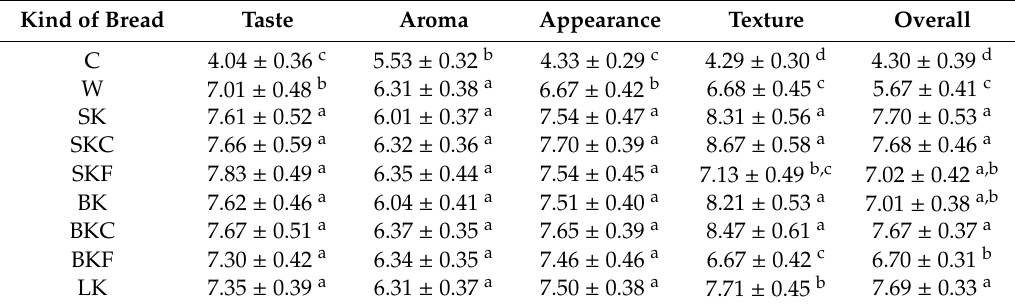
Table 3. Sensory evaluation of gluten-free bread with ground flaxseeds. Kind of Bread Taste Aroma Appearance Texture Overall C